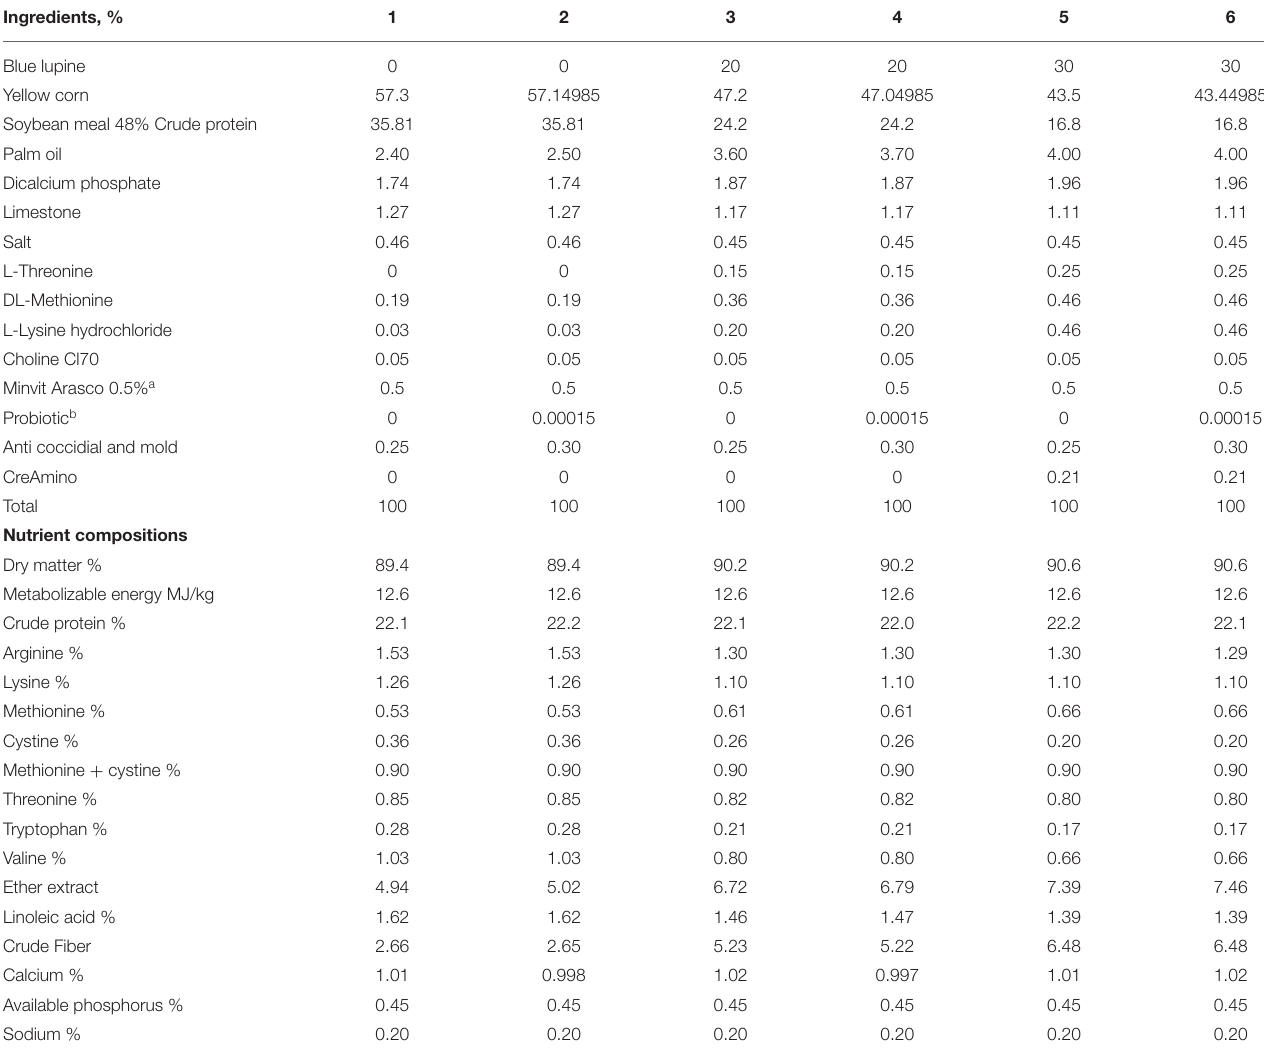
TABLE 1 | The composition of the diets used in the experiment (starter). Ingredients,